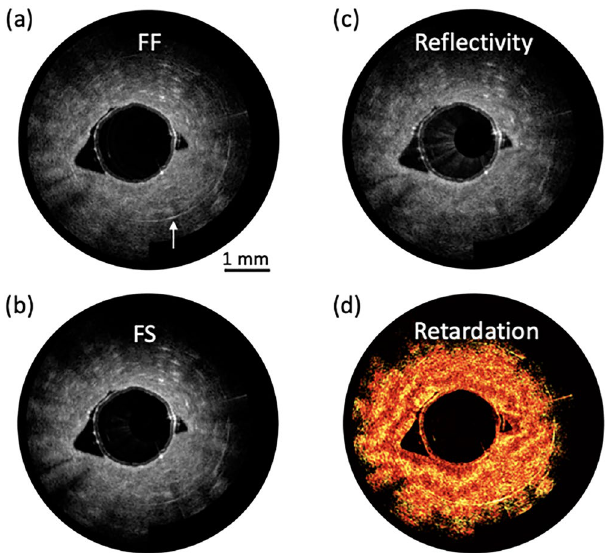
Figure 2. Images of chicken breast. ( a ) FF image, ( b ) FS image, ( c ) the normal image of reflectivity, and ( d ) the map of sample-field retardation of chicken breast. Scale bar: 1 mm. The image is generated by using Matlab. The figure is generated by using Matlab R2021a (Version: 9.10.0.1602886, https:// www. mathw orks. com/ produ cts/ new_ produ cts/ relea se202 1a. html).